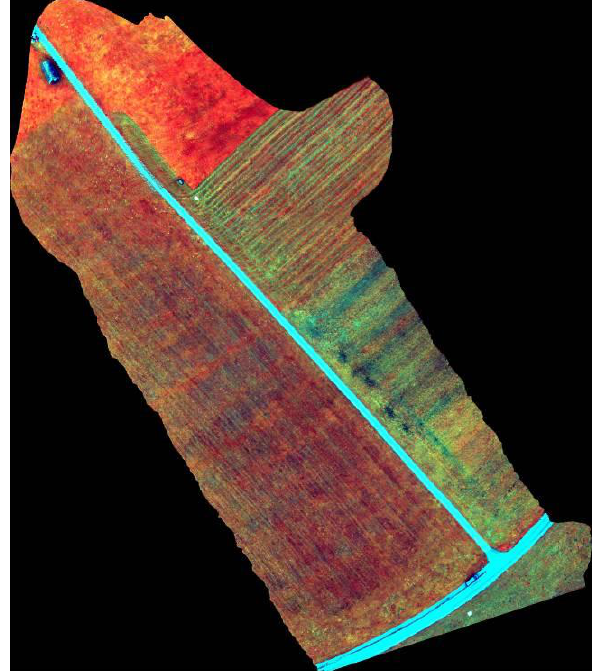
Figure 8: Verification of the time synchronization between IMU/GPS navigation sensor and hyperspectral camera